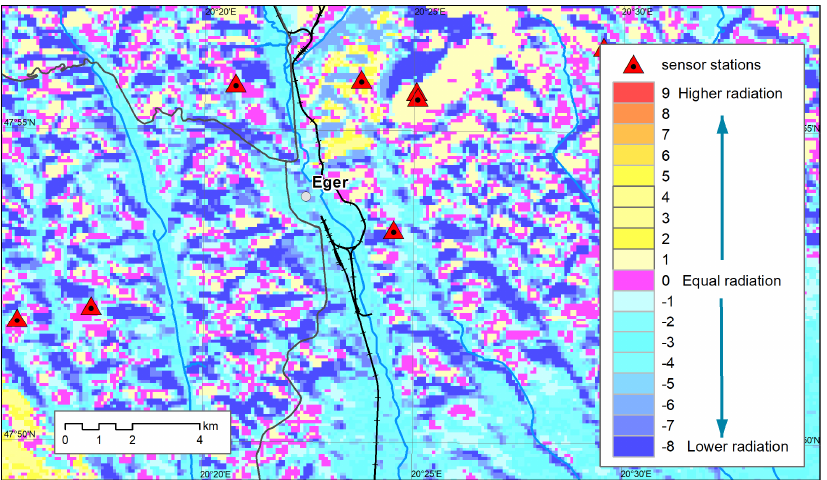
Figure 5. Differences in the amount of solar radiation on morpho-pedotops and sensor station sites (cut).